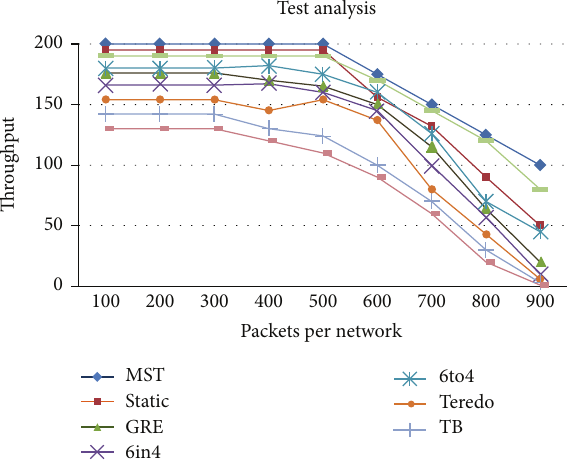
Figure 5: Throughput test